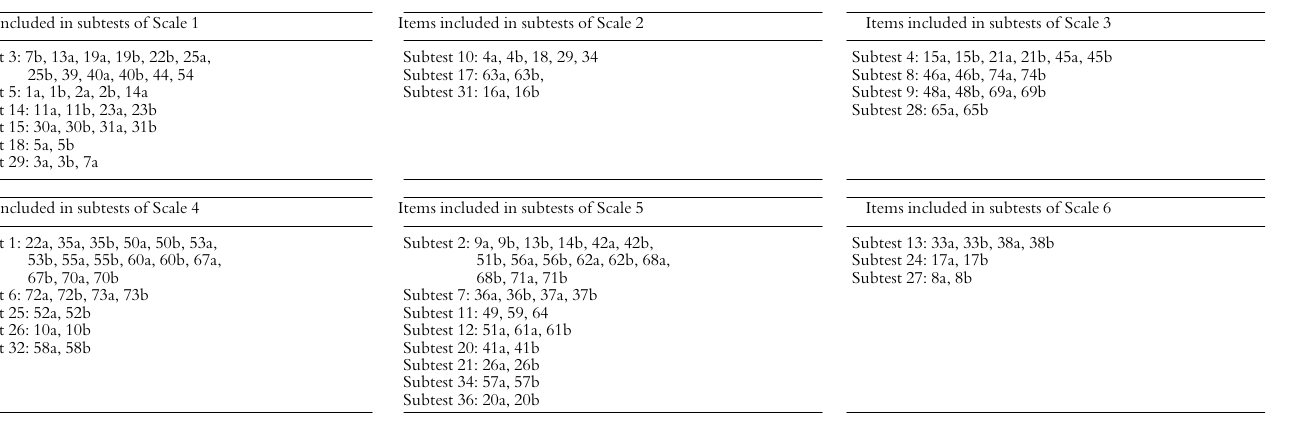
TABLE 7 ITEMSINCLUDEDIN THESUBTESTSOF THESIXSCALESOF